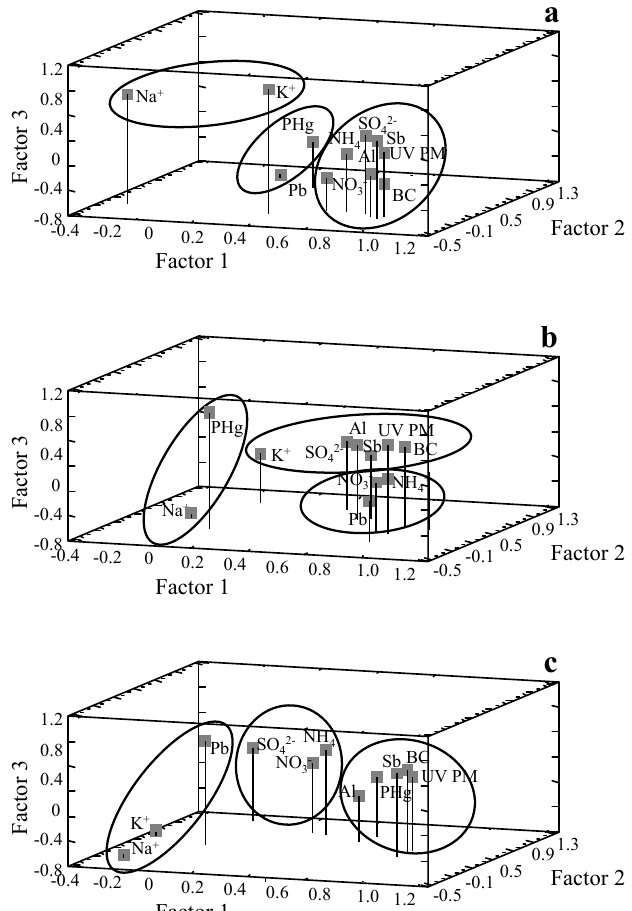
Figure 5. Three-dimensional plots of factor loadings for PM 10 mass, Na + , NH 4 + , SO 42 − , NO 3 − , Al, PHg, Pb, Sb, eBC and UVPM contents at industrial site during the whole period ( a ), summer ( b ) and winter ( c ) seasons.